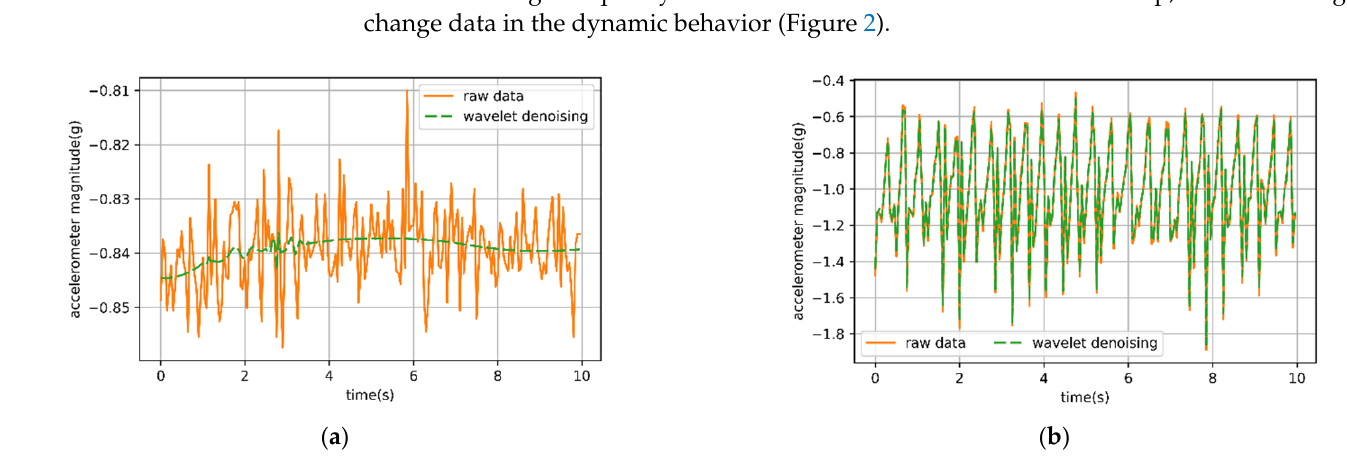
Figure 2. Comparison of the signal before and after wavelet denoising. ( a ) Time series of x -axis accelerometer signal from 20 Hz sampling rate for observed behaviors of 10 s lying; ( b ) time series of x -axis accelerometer signal from 20 Hz sampling rate for observed behaviors of 10 s walking.